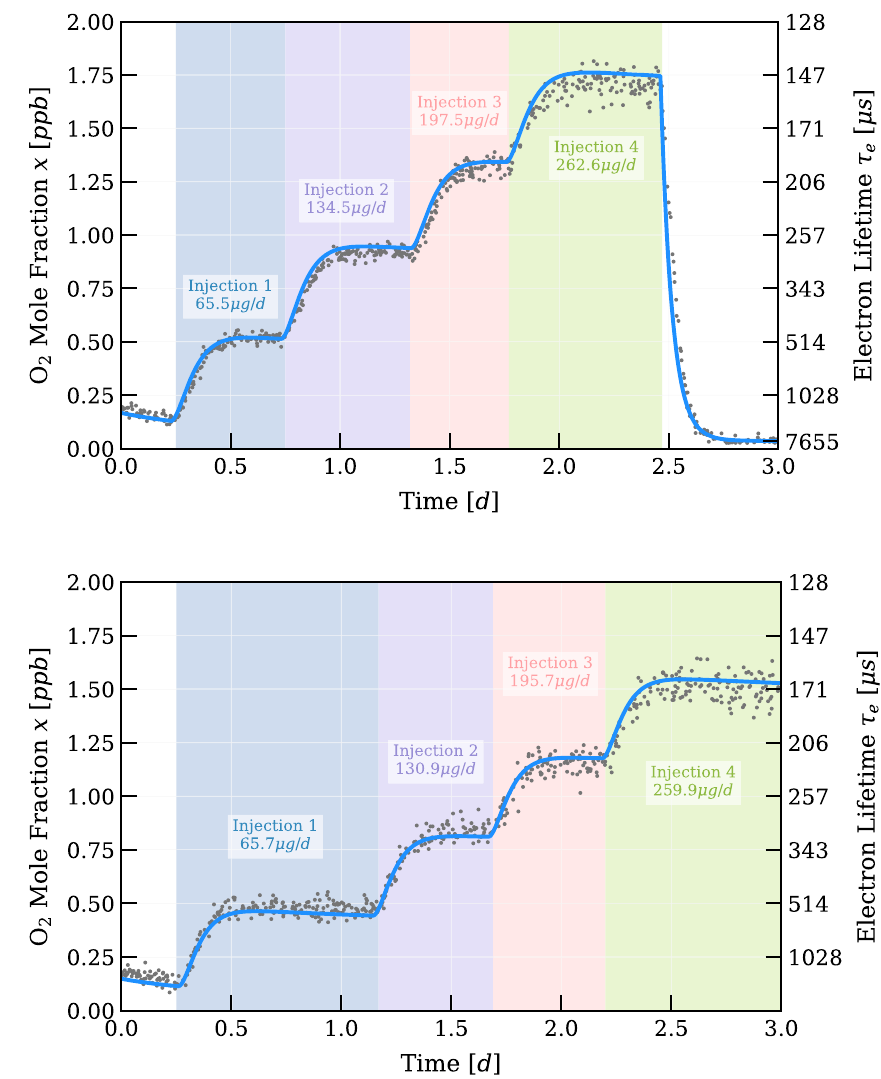
Fig. 8 Model (blue) of PM O 2 mole fraction x (gray) during the injection sequence performed with non-evaporable getter pills in the O 2 filter vessel. The colored regions indicate the different injection rates. The time dependence of the O 2 source Λ P is fixed by the equilibrium mole fractions before and after the injection sequence. The efficiency used is 0 .